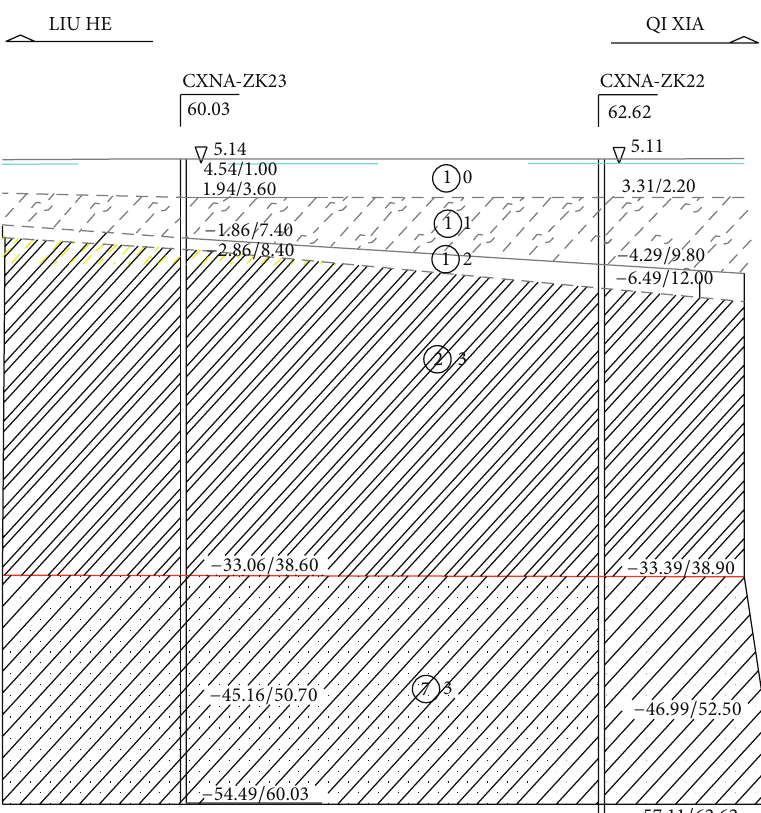
Figure 3: The soil profile of north anchorage of the Yangtze river 4th bridge A 0 = Clay, A 1 = silty clay, A 2 = silt, B 3 = silty clay with fine sand interbed, G 3 =